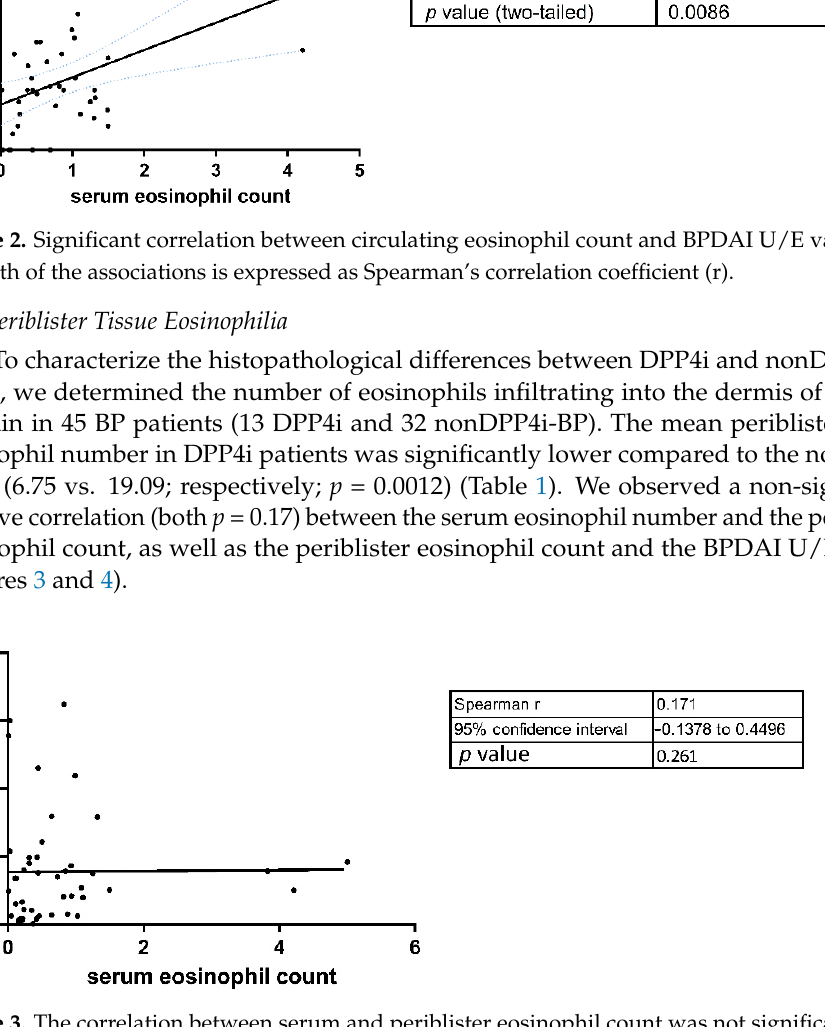
Figure 3. The correlation between serum and periblister eosinophil count was not significant.